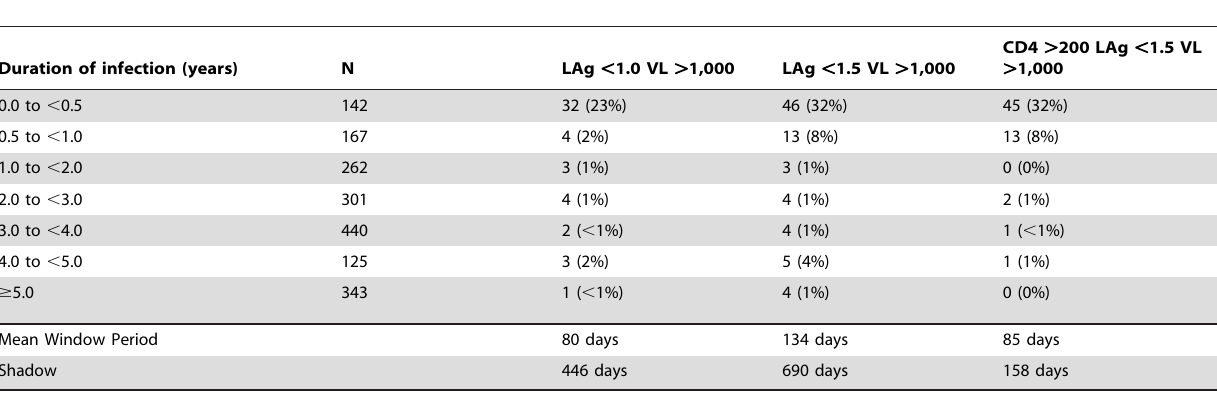
Table 2. Performance characteristics of MAAs that include the LAg-Avidity assay and HIV viral load, with and without CD4 cell count.